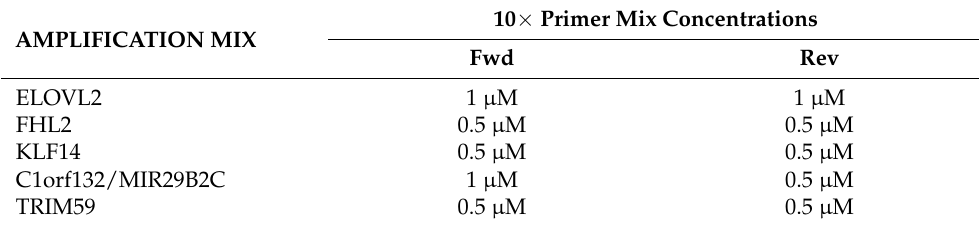
Table 4. First amplification 10 × primer mix forward and reverse primers’